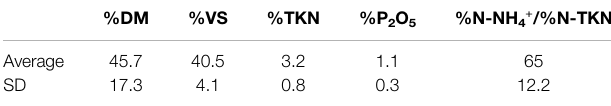
TABLE 5 | Sludge composition (average and SD) throughout the period (samples taken one week after resting) (n (cid:2)